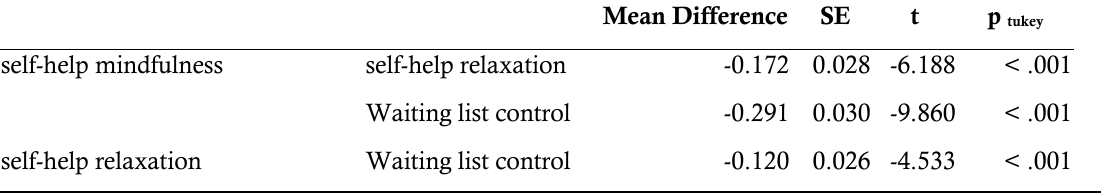
Table 3. Tukey Post-Hoc Comparasions of Anxiety Among Groups Mean